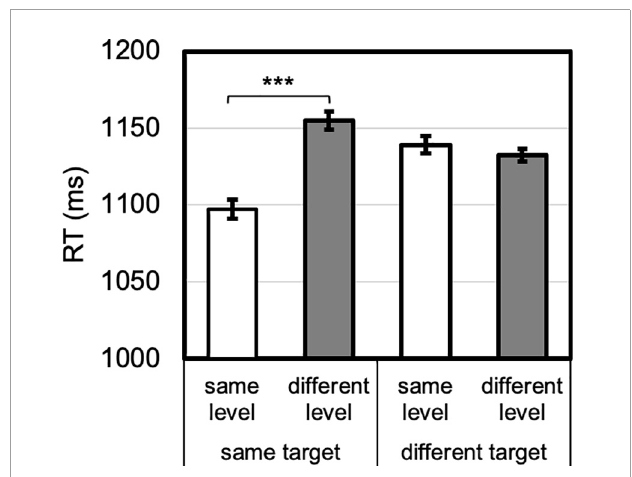
FIGURE4 Level priming by target priming interaction. Identity priming was present (same vs. different level for same target), whereas level-priming was not (same vs. different level for different target). Error bars reflect SE s adjusted for within-subjects comparisons, *** p <